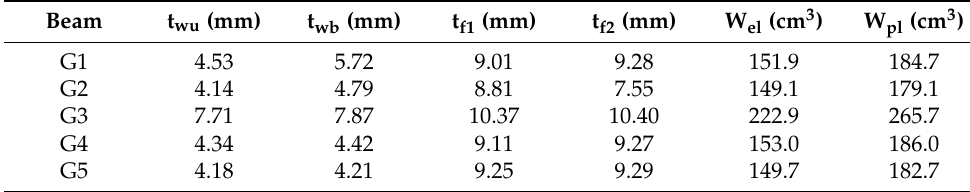
Table 2. Geometric characteristics of the simplified